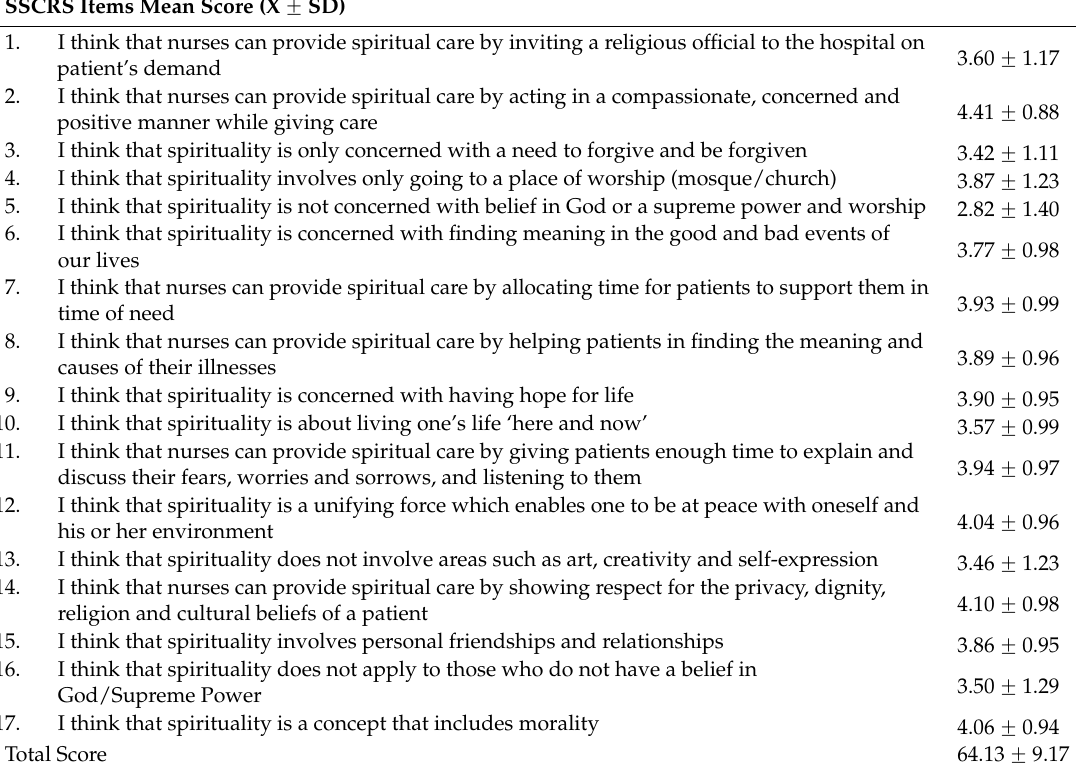
Table 4. Nursing students’ mean scores of Spirituality and Spiritual Care Rating Scale (SSCRS) items ( n =